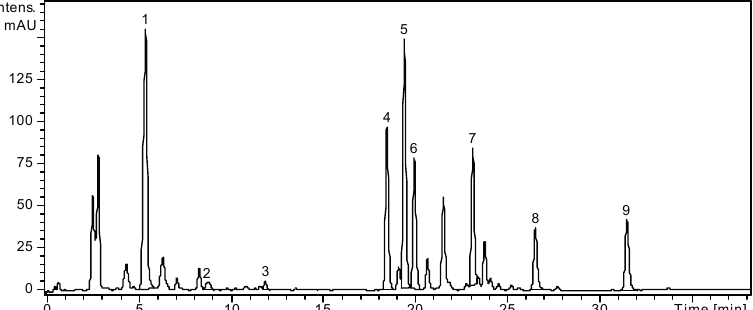
Figure 1. HPLC chromatogram of S. chinensis leaves extract.